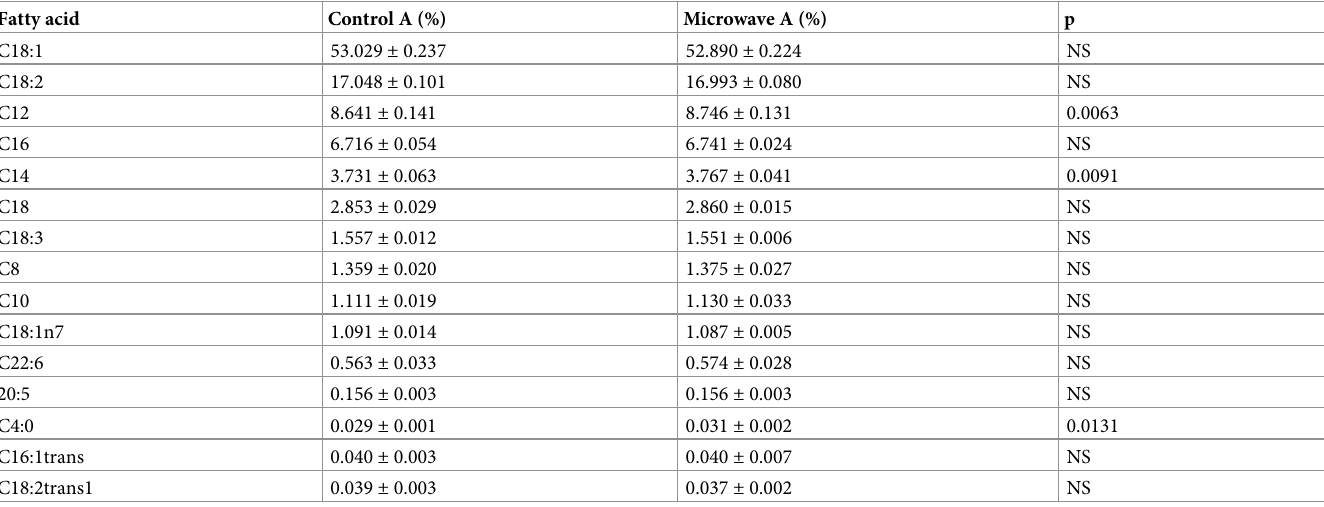
Fatty acids representing > 0.5% of total are presented, as well as the eicosapentaenoic acid (EPA) and other fatty acids, for which differences were found. The complete data are presented in S2